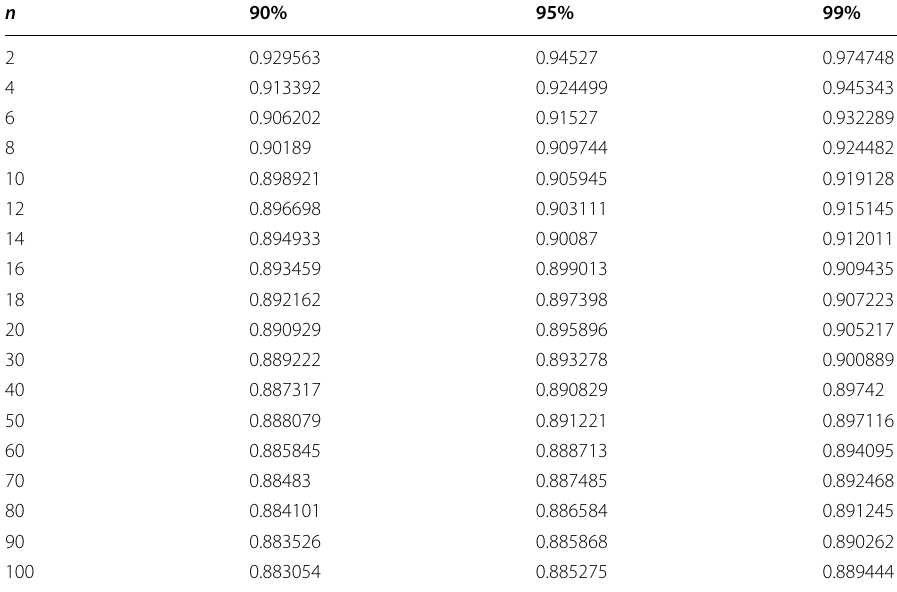
Table 4 Critical values of ˆ (cid:31) c U